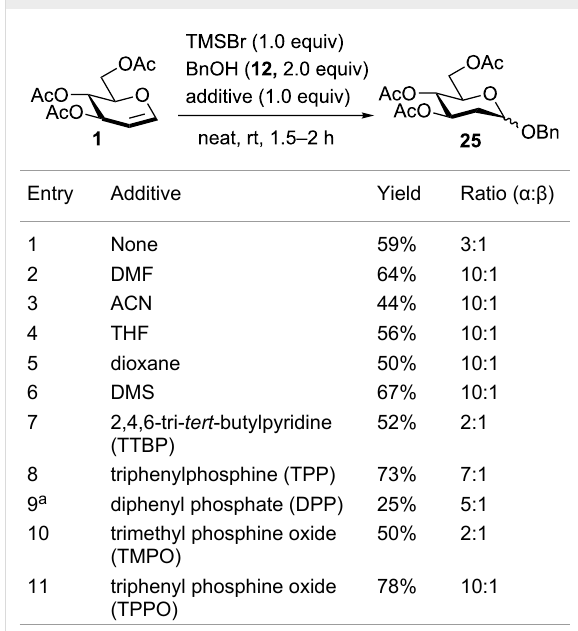
Table 2: Additives in TMSBr-mediated 2-deoxyglycosylation of glucal 1